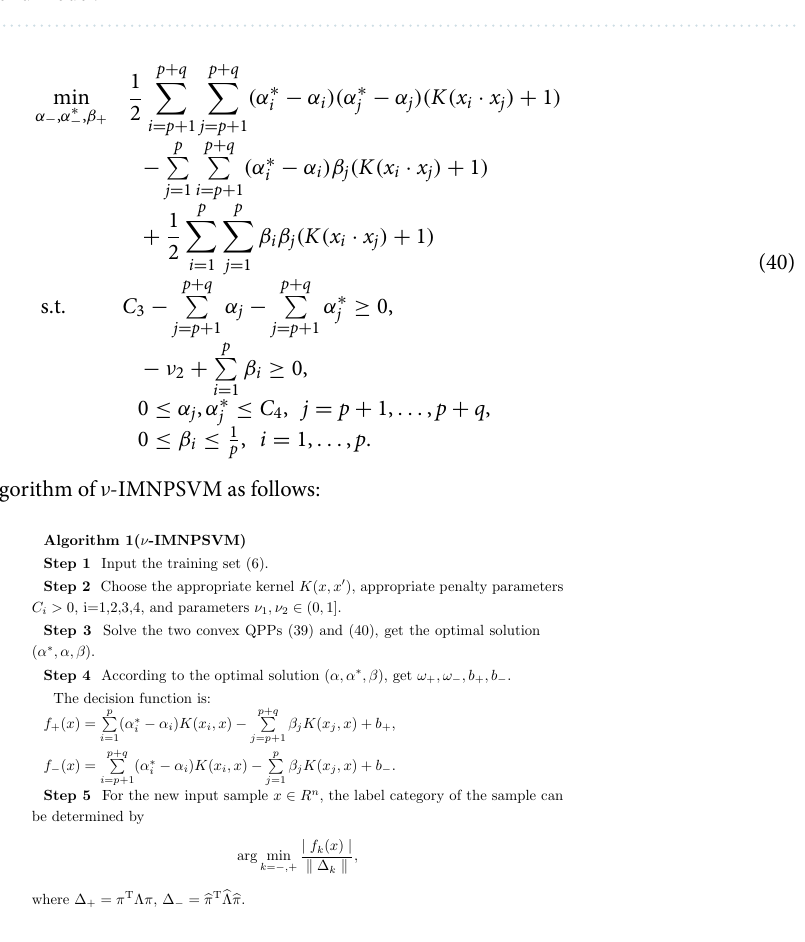
Figure 2. Percentage of SVs change when ν 1 , ν 2 vary in the ν -IMNPSVM two problems. Figure ( a ) is the percentage of the negative SVs in the first ν -IMNPSVM model (35) corresponding to the parameter ν 1 , the red line is the real percentage of negative SVs rates, and the blue one is the value of ν 1 . Figure ( b ) is the percentage of the positive SVs corresponding to the parameter ν 2 in the problem (37). ( a ) Negative SVs in the first model, ( b ) positive SVs in the second